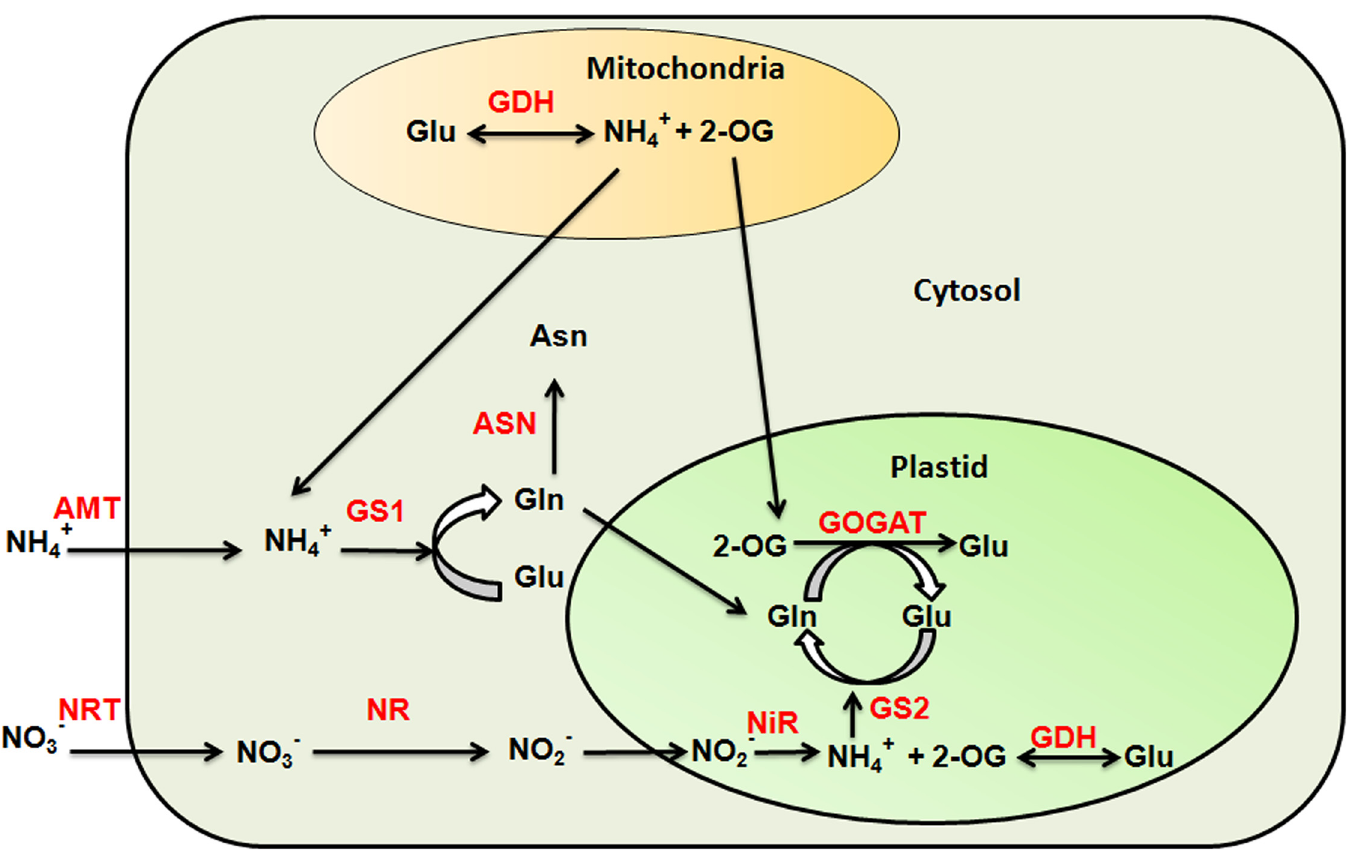
Fig 1. Nitrogen uptake and assimilation process in plants. The uptake of nitrate (NO 3- ) and ammonium (NH 4+ ) ions is mediated by nitrate (NRT) and ammonium transporters (AMT), respectively. The NO 3- entered into the cell is reduced to nitrite ions (NO 2- ) by an enzyme nitrate reductase (NR). The nitrite ion then moves to plastid and reduced to ammonium ion by nitrite reductase (NiR) enzyme. The ammonium is then incorporated into amino acid by glutamine synthetase and glutamate synthase via GS/GOGAT cycle. The ammonium ion transported by ammonium transporters directly enters into GS/GOGAT cycle. The two additional enzymes glutamate dehydrogenase (GDH) and asparagine synthetase (ASN) also participates in ammonium assimilation. The GS, GDH and ASN are the key enzymes involved in synthesis of glutamine (Gln), Glutamate (Glu) and Asparagine